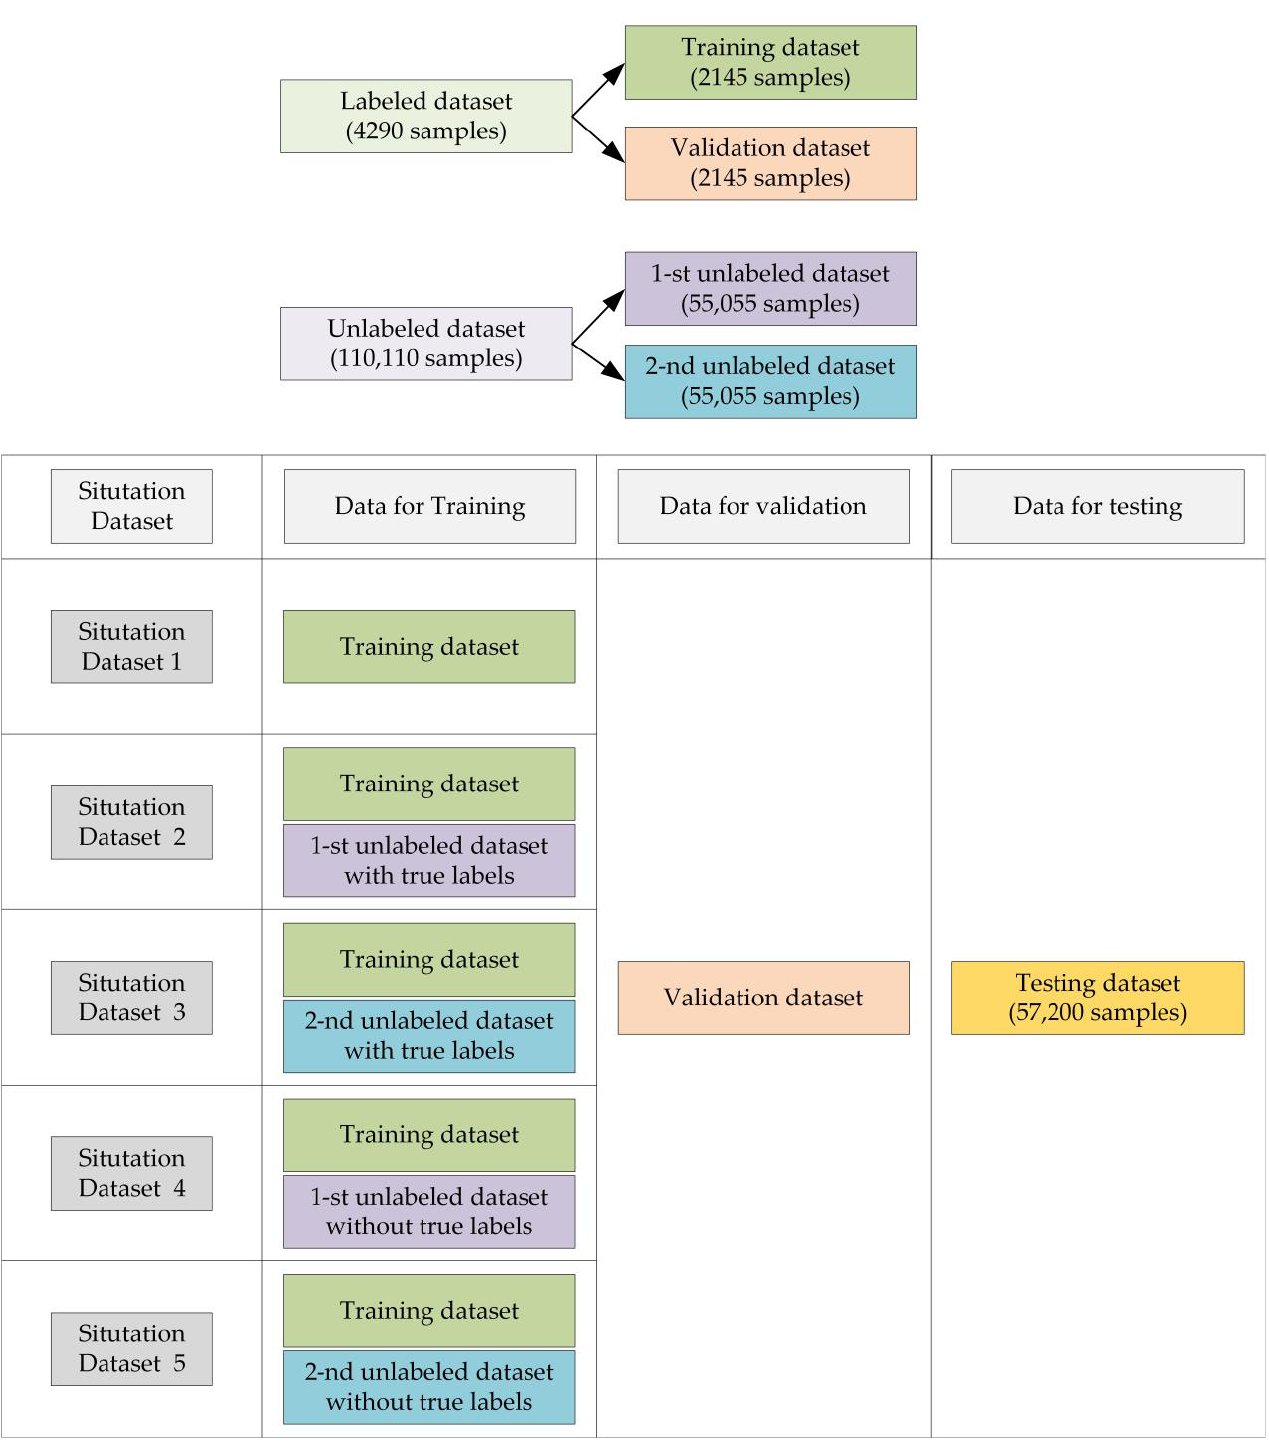
Figure 5. The datasets in different